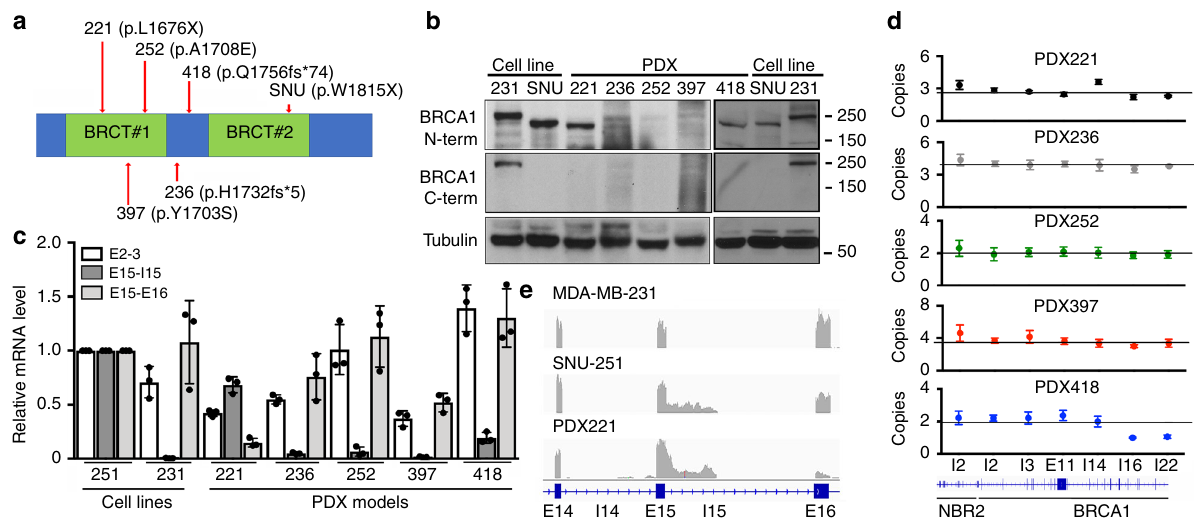
Fig. 6 BRCA1-I15 is expressed in patient-derived tumors. a Cartoon showing the location of BRCA1 mutations present in PDX models relative to BRCA1 BRCT repeats. See Supplementary Table 2 for more information. b PDX tumors were examined for BRCA1 protein expression using N- or C-terminal-speci fi c antibodies by Western blotting. MDA-MB-231 (231) and SNU-251 (SNU) cells are comparators. c BRCA1 exons 2 – 3, intron 15, and exons 15 – 16 mRNA expression in the PDX samples measured by qRT-PCR. MDA-MB-231 (231) and SNU-251 (SNU) cells are included as comparators. d Copy